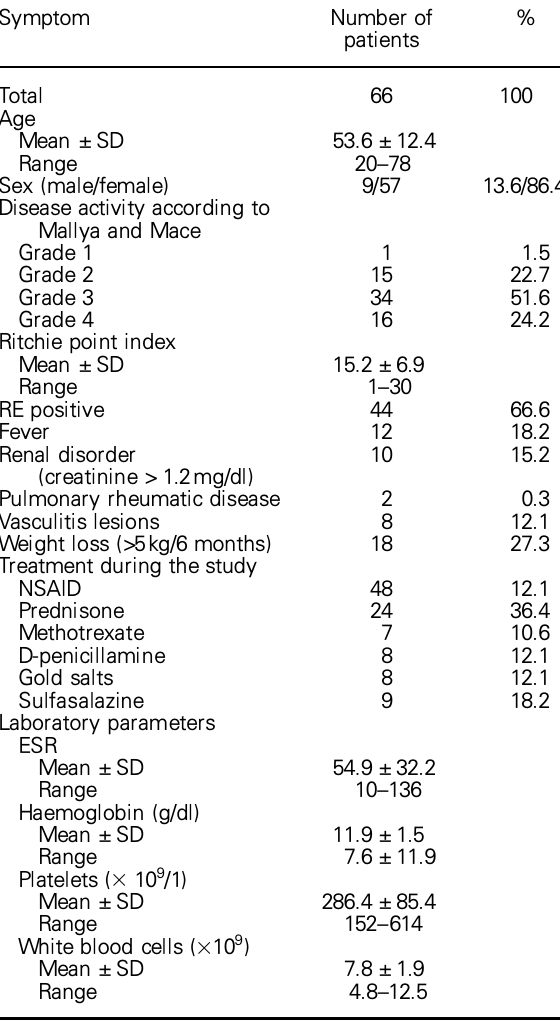
Table 1. Clinical characteristics of patients with rheumatoid arthritis